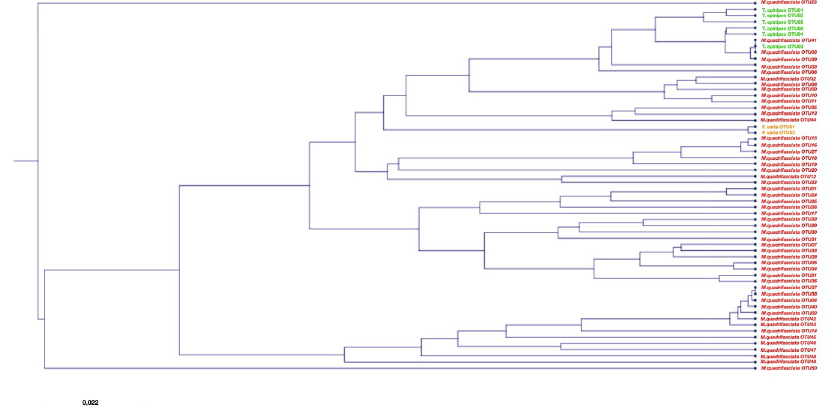
Fig 5. Phylogenetic affiliation of Escherichia coli associated with brazilian stingless